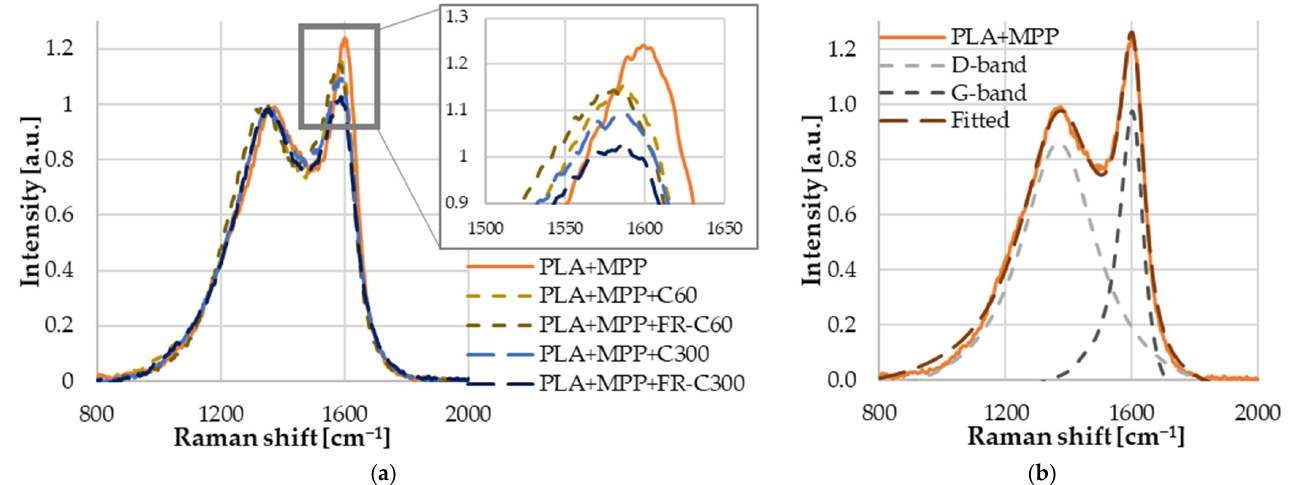
Figure 8. ( a ) Raman spectra of the charred composites normalised to the D-band; ( b ) Example of the fitted D and G bands on the Raman spectrum of PLA + MPP composite’s char. Table 10. Area ratios of the fitted D and G bands of the char residues.